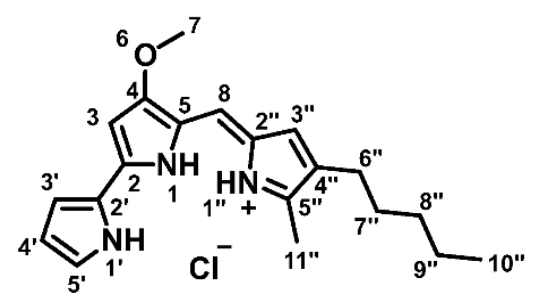
Figure 1. Chemical structure of prodigiosin.